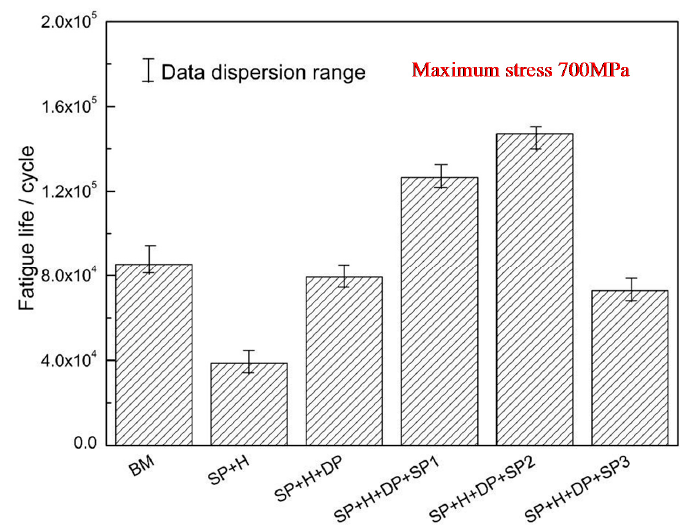
Figure 9. Fatigue life comparison of TC21 specimens with different surface state.